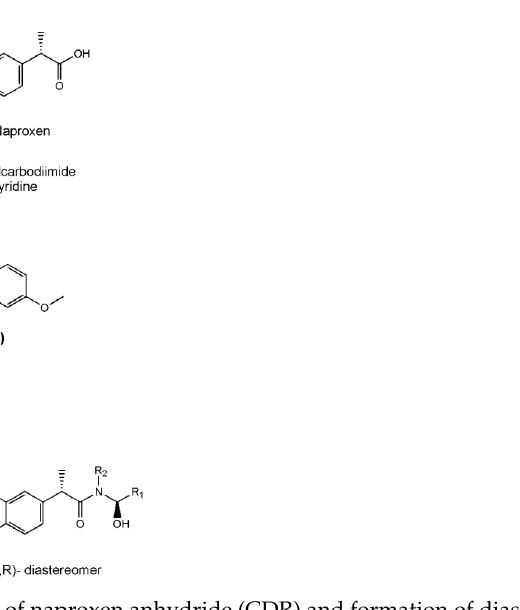
Figure 1. The preparation procedure of naproxen anhydride (CDR) and formation of diastereomers of β -blockers [95].